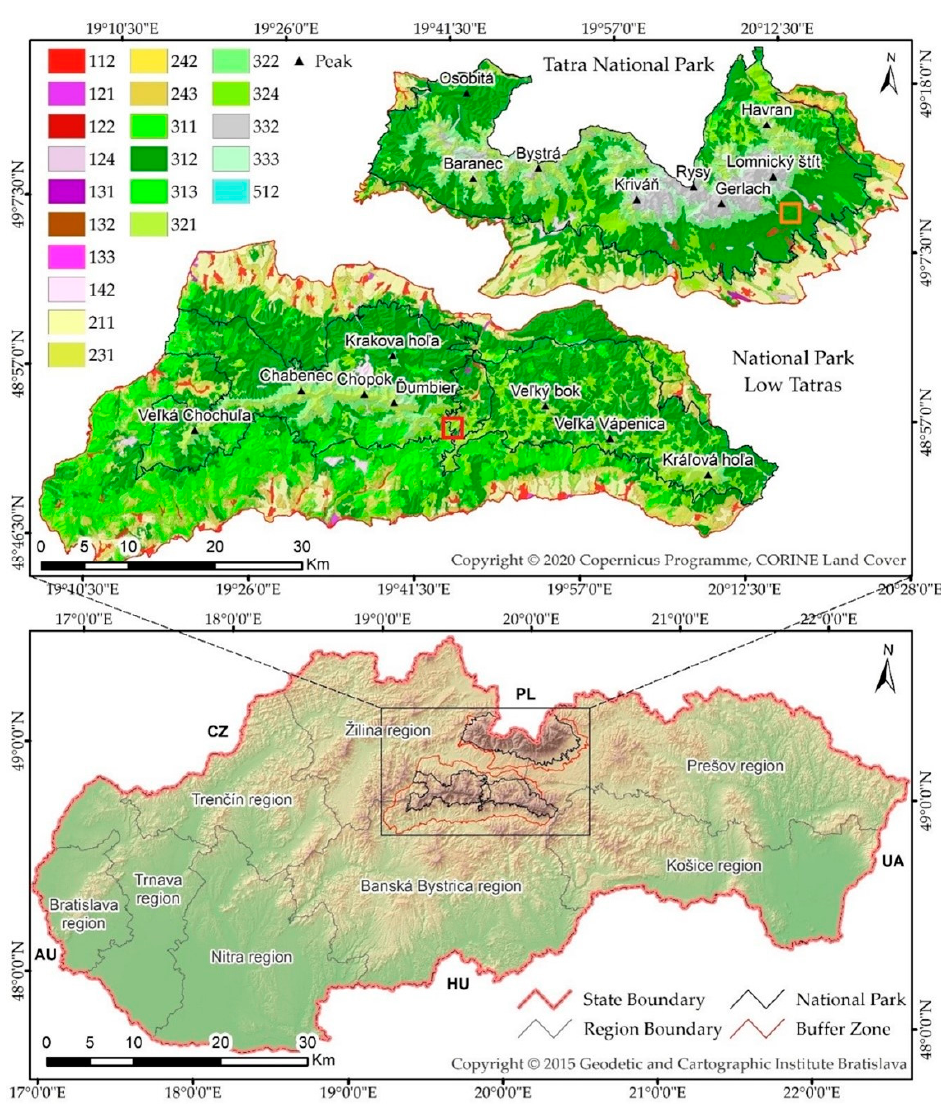
Figure 1. Localization of TANAP and NAPALT with the CORINE Land Cover 2018 inventory in Slovakia. Local studies: orange square—Vicinity of Tatranská Lomnica, red square—Surroundings of ˇCertovica. Description of the land cover classes (codes) in the legend is available at the following link: https://land.copernicus.eu/pan-european/corine-land-cover (accessed on 10 March